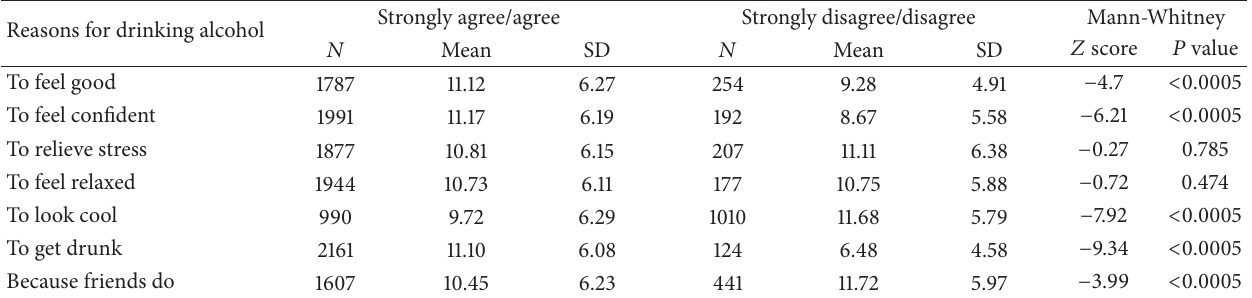
Table 3: Reasons for drinking